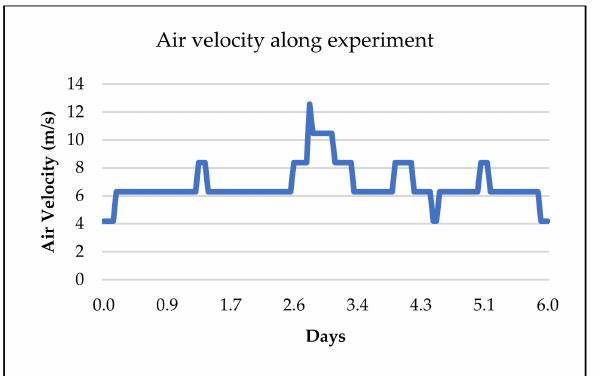
Figure 6. Measured heat transfer fluid (HTF) velocity during continuous cycling for TES modules over a period of 6 days.